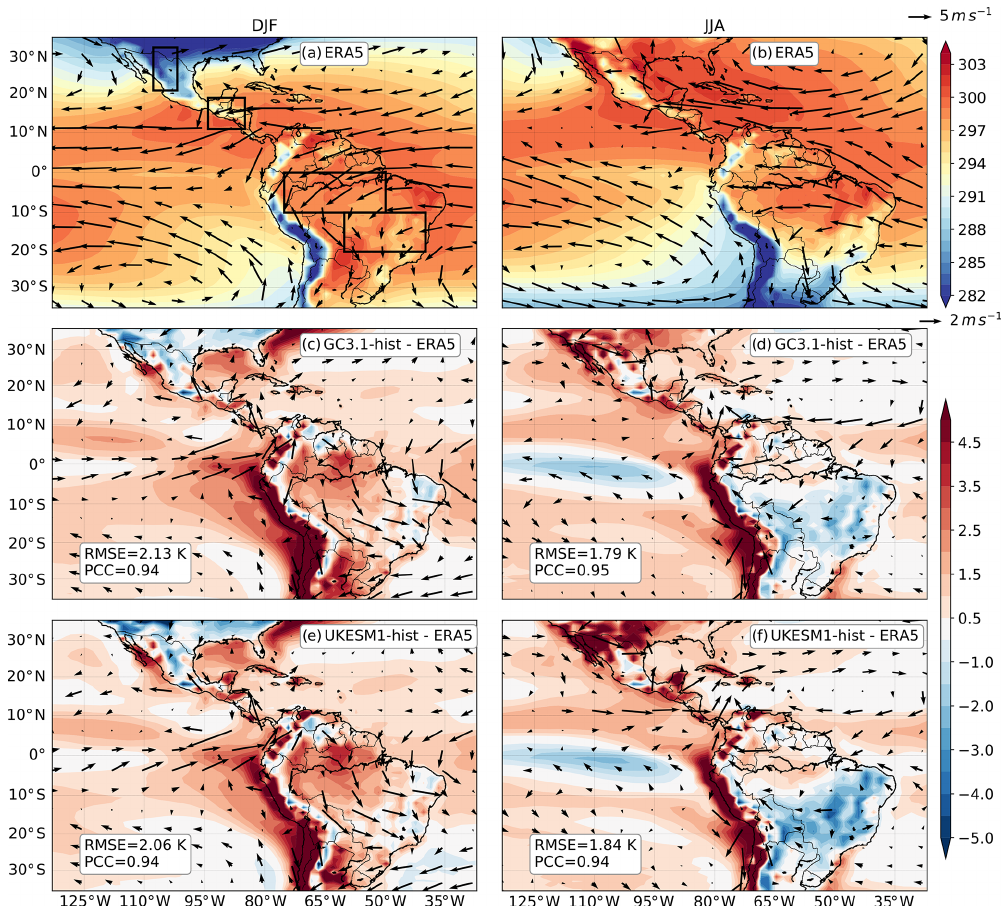
Figure 1. (a, b) Temperature (colour contours in K) and wind speed (vectors) at 850hPa DJF and JJA climatologies in ERA5. The biases are shown as the differences between the ensemble mean from the historical experiment of (c, d) GC3 and (e, f) UKESM1 and ERA5. The climatologies and biases are shown for (a, c, e) boreal winter (DJF) and (b, d, f) boreal summer (JJA). Only differences statistically significant to the 95% level are shown, according to a Welch t test for each field. The key for the size of the wind vectors is shown in the top right corner of panels (b) and (d) . The root-mean-square error (RMSE) and pattern correlation coefficient (PCC) are shown in the bottom left of (c) – (f)